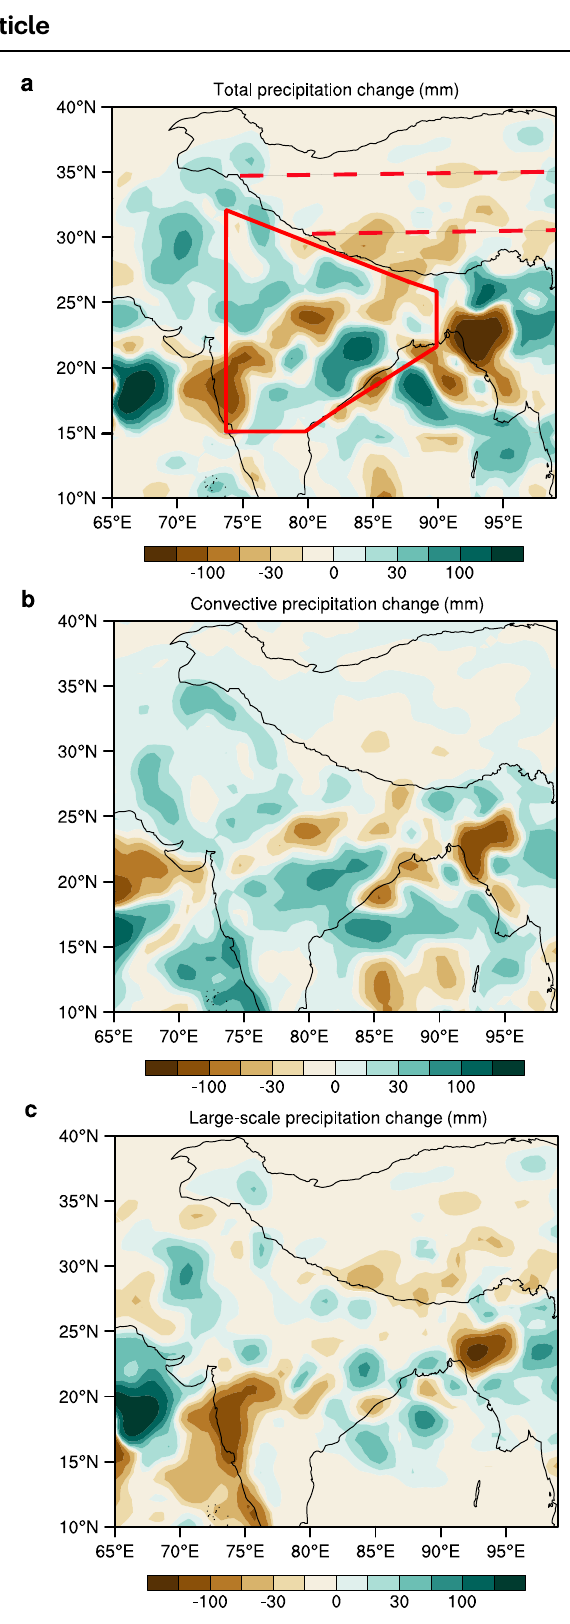
Fig. 3 | Summer precipitation change simulations using the Weather Research and Forecasting model with Chemistry (WRF-Chem). a Averaged summer pre- cipitationchangeduetoSouthAsianblackcarbonfortheperiod2007 – 2016;thisis then broken down into two components in b convective precipitation and c large- scale precipitation. Precipitation change estimates were derived based upon WRF- Chem simulations, where precipitation output from the control simulations (initi- alized with South Asian black carbon) was compared with that from the sensitivity simulation (devoid of South Asian black carbon). South Asia is delineated by the solidredpolygonandtheTibetanplateauisoutlinedbyreddashedlinesdepicting its northern and southern regions, as noted in Fig.